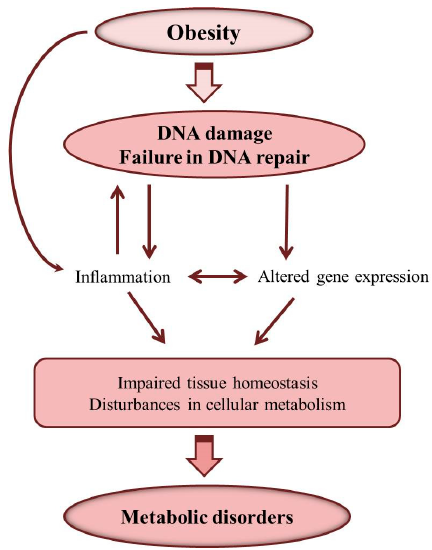
Figure 3. Obesity-induced DNA damage and development of metabolic disorders.